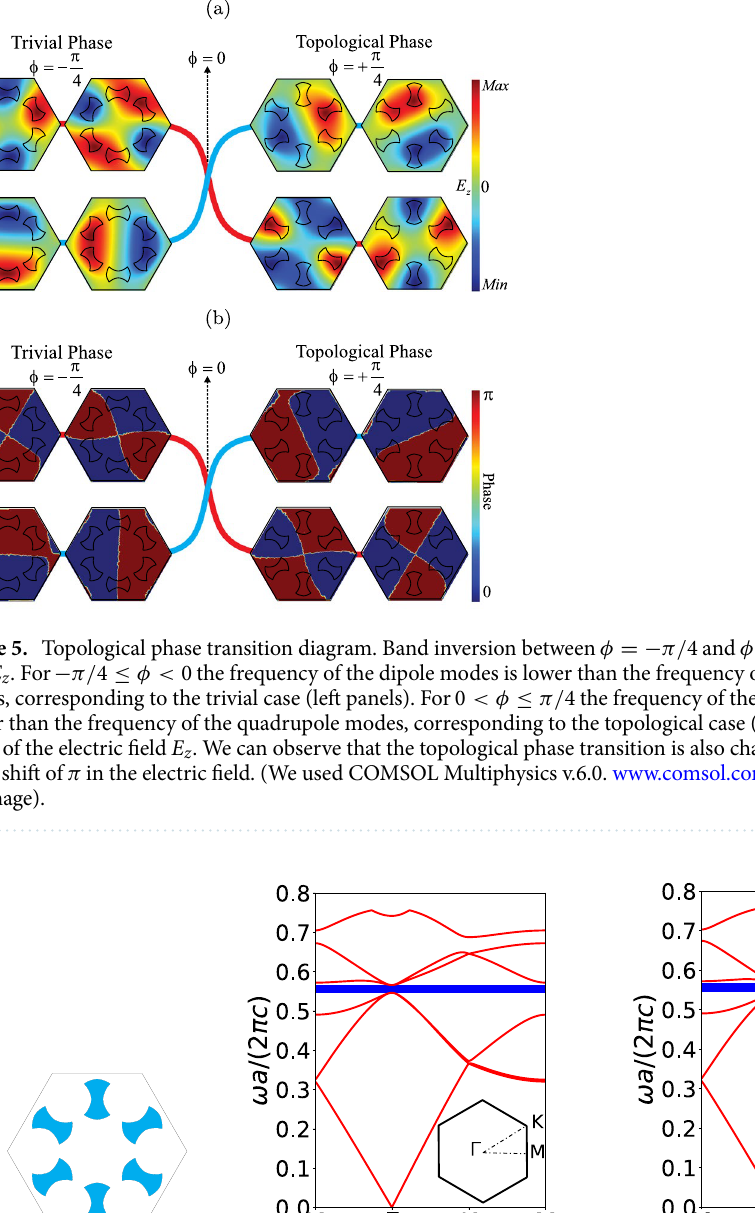
Figure 6. Results for the perturbed photonic crystal. Scheme of the unit cell with ( a ) φ φ π/ 4 . ( c ) Band structure for the TM modes with ε = π/ 4 ). ( d ) The same for the topological case ( φ the trivial case ( φ = − shaded